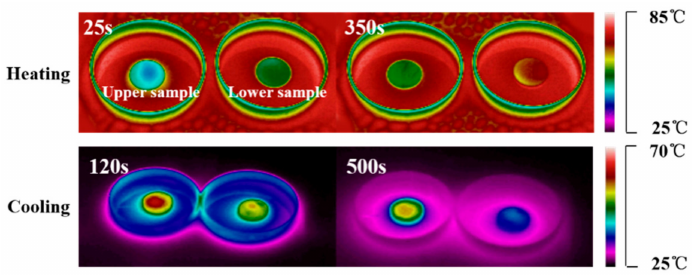
Figure 6. Infrared ray (IR) images of upper and lower samples of SAT / 5 wt.% DSP during heating and cooling